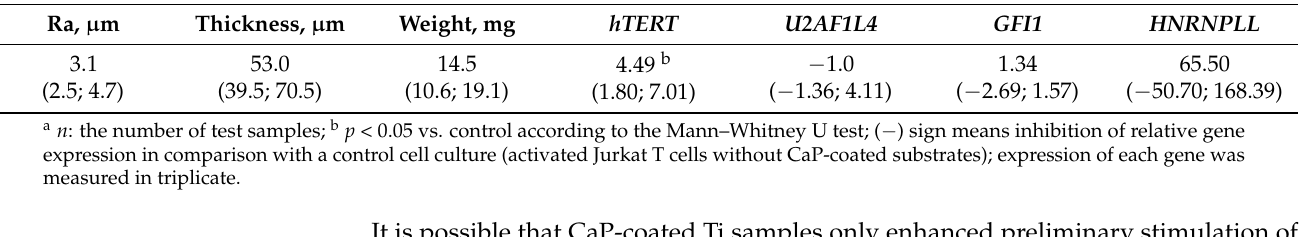
Table 2. Relative gene expression levels (fold) in Jurkat T cells preactivated with anti-CD2/CD3/CD28 antibodies and collected from plastic after 14 days of in vitro coculture with the micro-arc CaP-coated titanium substrates, Me (Q1; Q3). Parameters of Bilateral CaP Coating Relative Expression of on a Titanium Substrate, n = 3 a